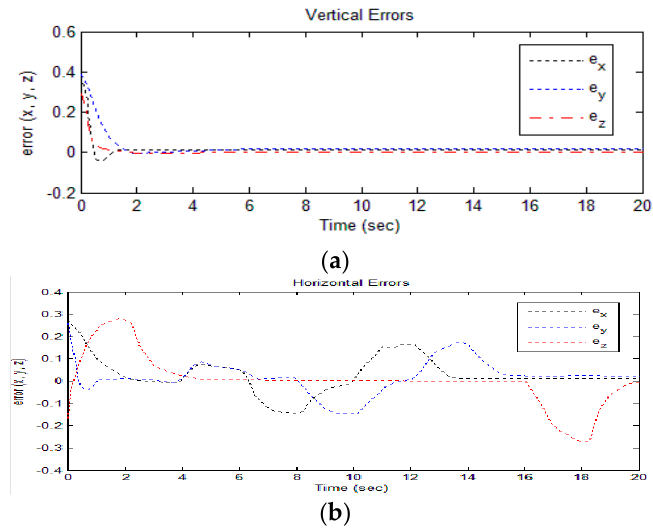
Figure 14. ( a ) Vertical errors of the trajectory tracking in the x , y , and z directions; ( b ) horizontal errors of the trajectory tracking in the x , y , and z directions.